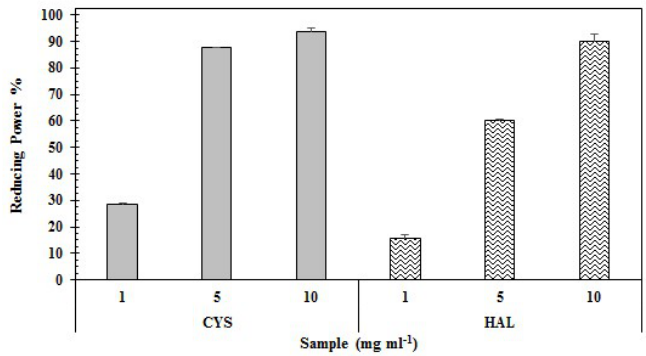
Figure 3. Reducing power (%) of CYS and HAL aqueous extracts at different concentrations.